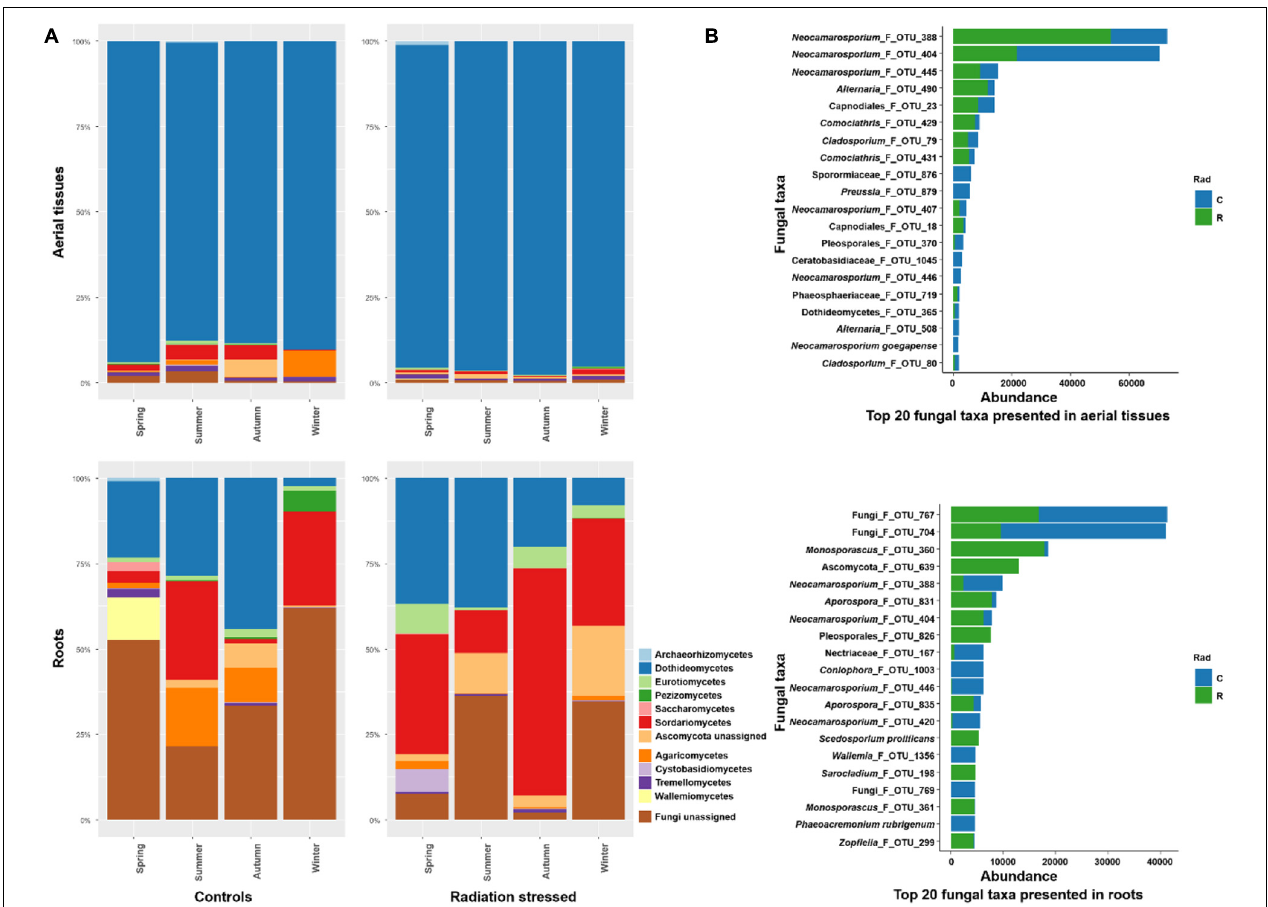
FIGURE 2 | Taxonomical composition of endophytic fungi on Kalidium schrenkianum . (A) Relative abundance of top 12 fungal phyla presented in aerial tissues and roots over various seasons at two sampling sites. (B) The abundance of top 20 fungal species or OTUs in the aerial tissues (upper) and roots (bottom). Blue bars indicate fungal abundances in the control site, and green bars indicate abundances in the radiation stressed